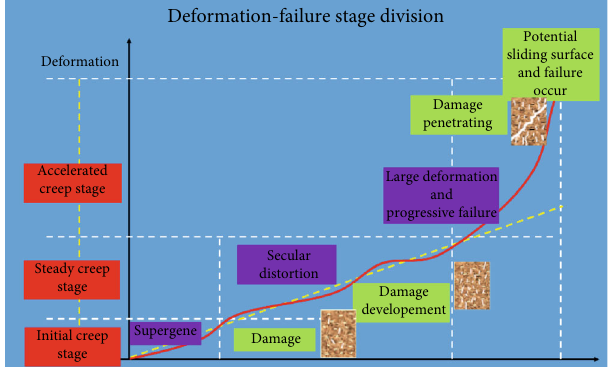
Figure 9: Deformation-failure evolution process of